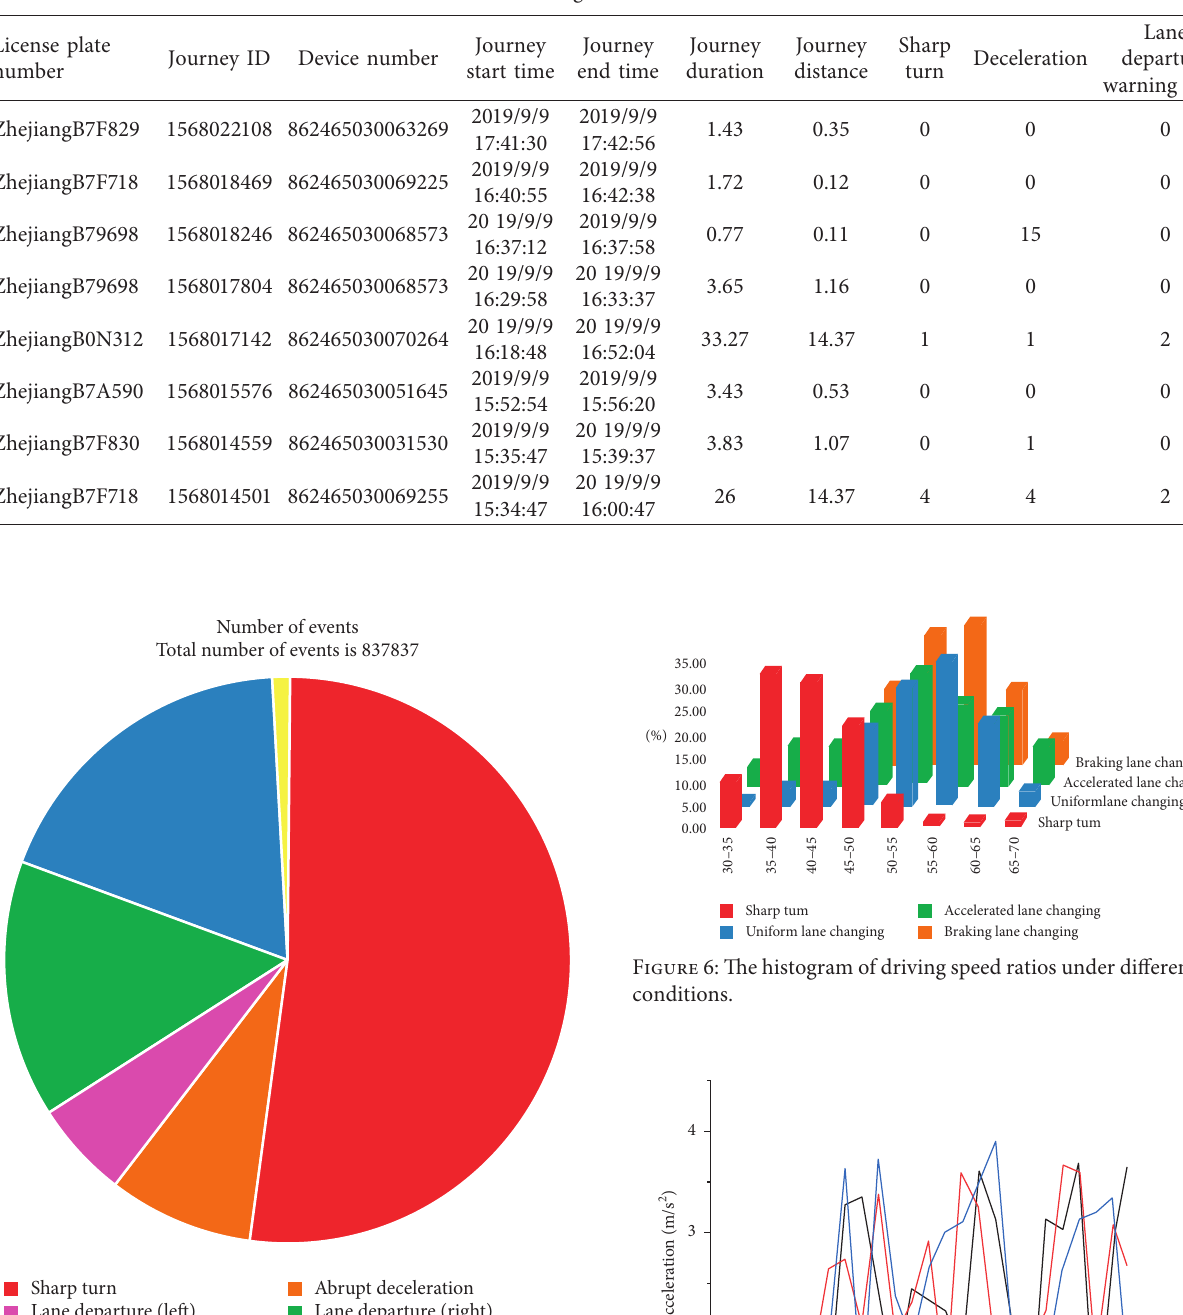
Table 1: Driving condition data center.